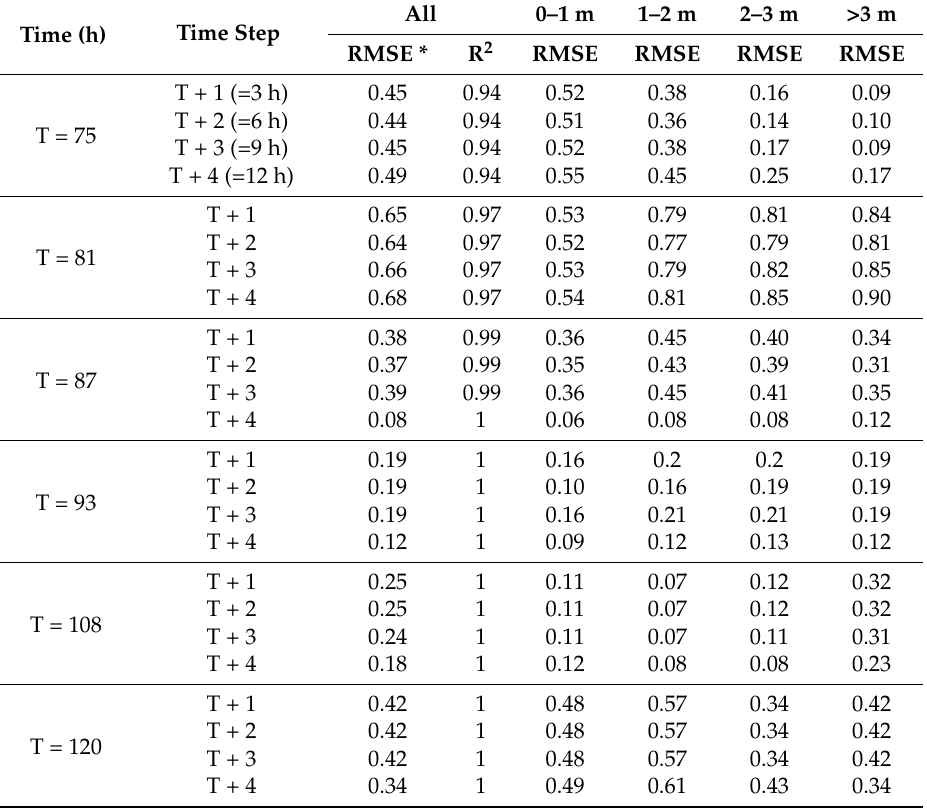
Table 6. Performances of the SOM − RNARX model (time step = 3 h) with respect to different inundation depths over time for Event 7, taking the simulation model as a